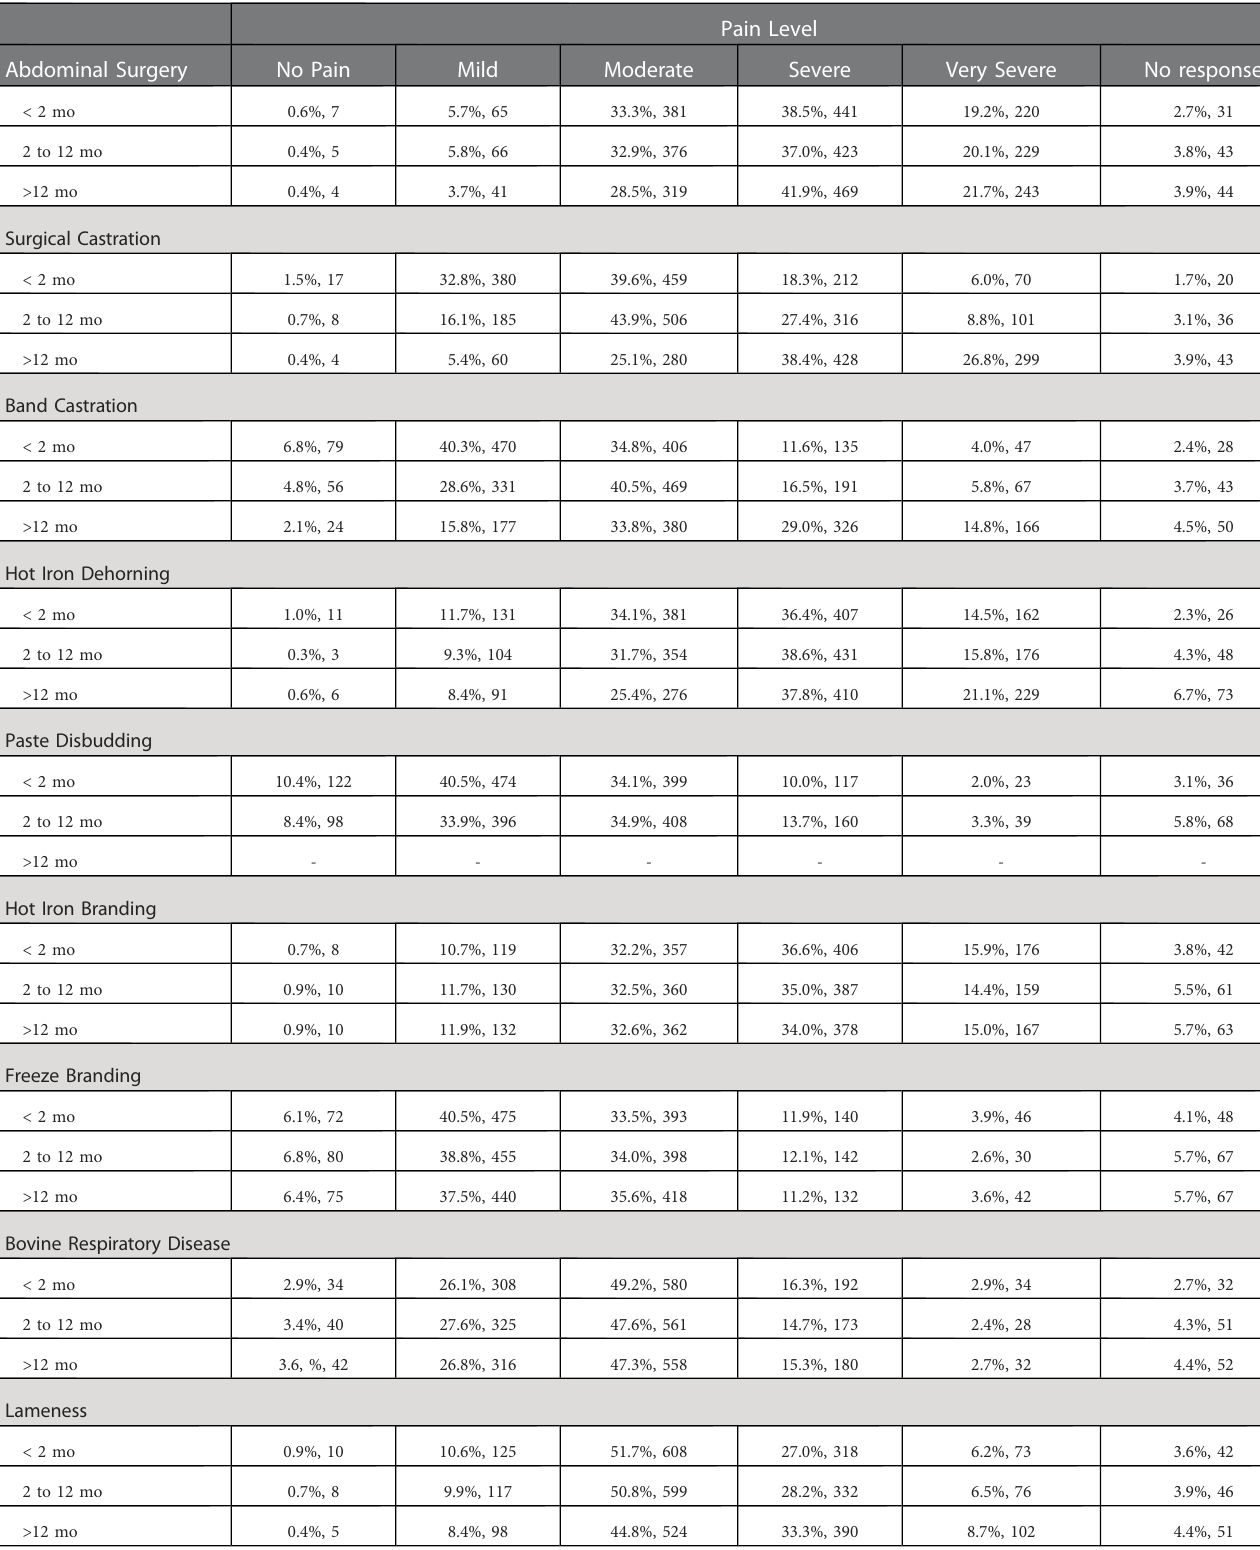
TABLE 1 Distribution of pain perceptions (e.g., No Pain, Mild, Moderate, Severe, Very Severe) across different cattle age groups (e.g., < 2 months, 2 - 12 months, > 12 months) and procedures or conditions for all survey respondents 1